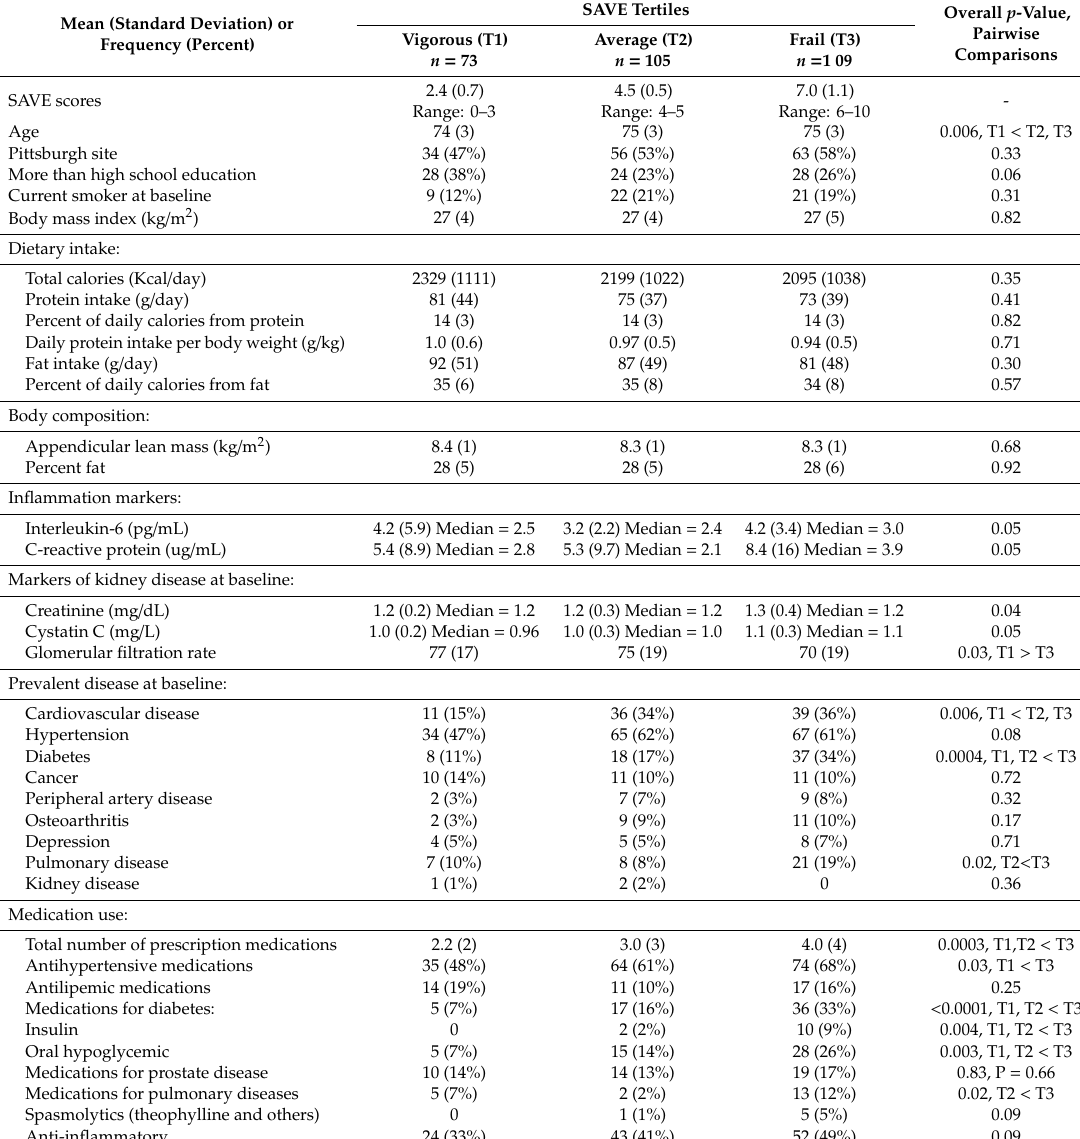
Table 1. Characteristics of 287 black men from the Health, Aging, and Body Composition study by tertiles of scores on the Scale of Aging Vigor in Epidemiology